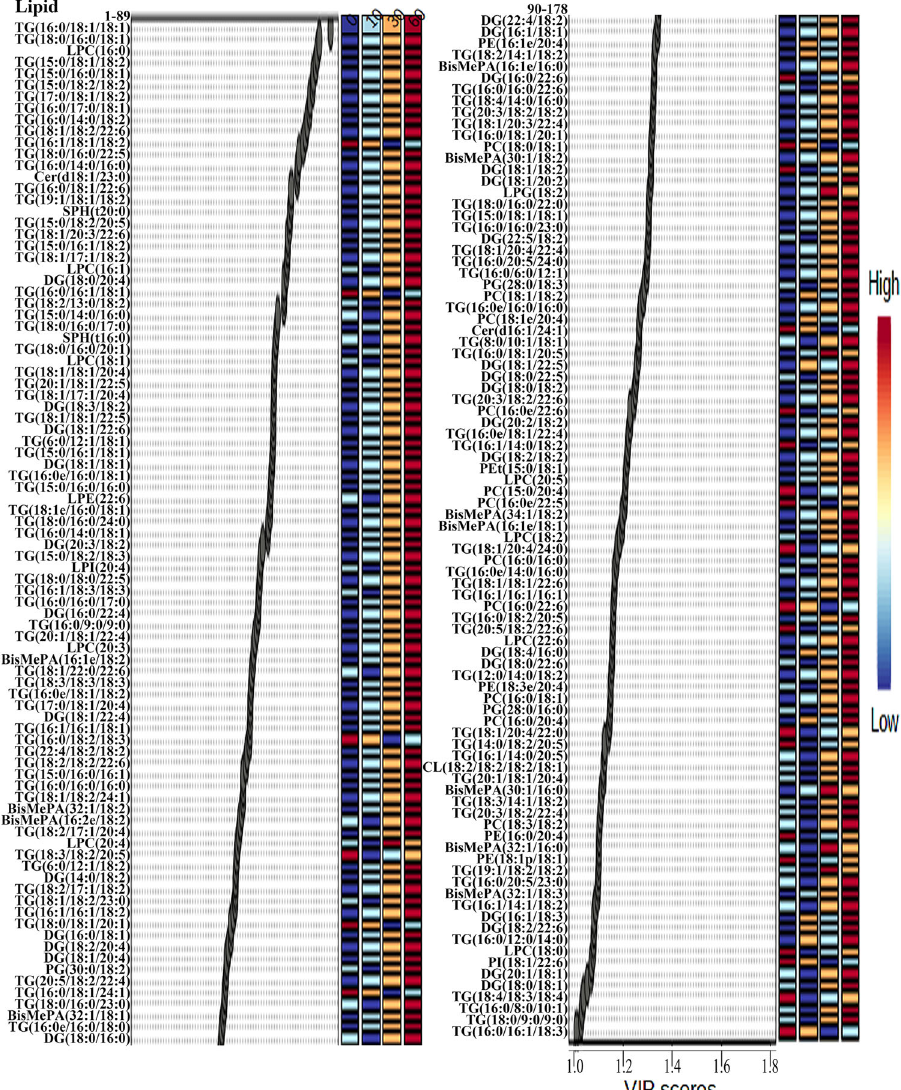
Fig. 7 VIP scores in PLS-DA of the sum individual lipids in tilapia muscle and juice at different steaming times by Metaboanalyst 5.0 software according to the normalized MS data. The colored boxes on the right of VIP score images indicate the relative peak area of the corresponding lipid classes. Each colored cell in the heat map corresponds to a peak area value of the lipid classes on the right side. In the colored cells, red color is high and blue color is